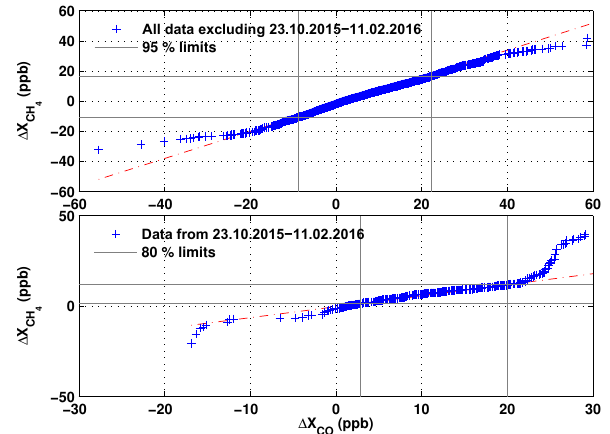
Figure 2. These quantile–quantile plots show the extent to which (cid:49) X CH and (cid:49) X CO anomaly data from the Caltech FTS are from 4 the same probability distribution. When the distributions of the two datasets are similar, the points (blue “ + ”) fall along the red dashed line. The top panel shows the quantile–quantile plot of methane and carbon monoxide from data prior to the Aliso Canyon gas leak, which started on 23 October 2015. The plot is linear between the grey lines, which indicate the 95% quantiles of (cid:49) X CO and (cid:49) X CH . 4 We use these limits to define air that is representative of “ambi- ent” SoCAB air from air that contains plumes during that time pe- riod. The bottom panel shows the quantiles of (cid:49) X CH and (cid:49) X CO 4 anomaly data for the time period after the Aliso Canyon gas leak be- gan. For this time period, 80% quantiles were chosen to distinguish between ambient and plume